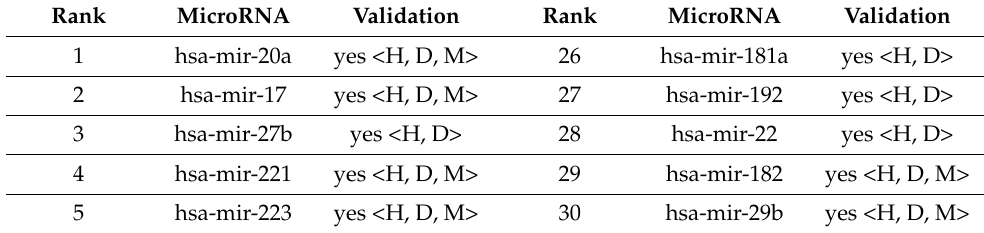
Table 6. Top 50 miRNAs predicted by HLGNN-MDA to be associated with renal cell carcinoma.